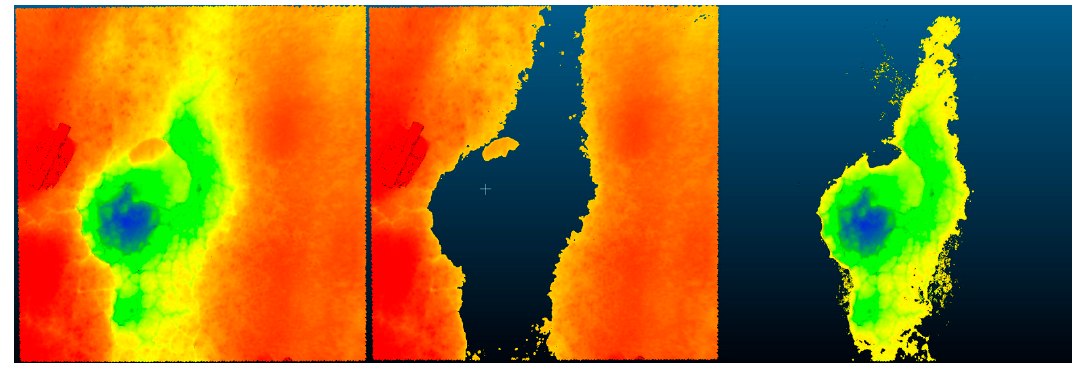
Figure 31. Segmented pavement section 3 using fit plane.